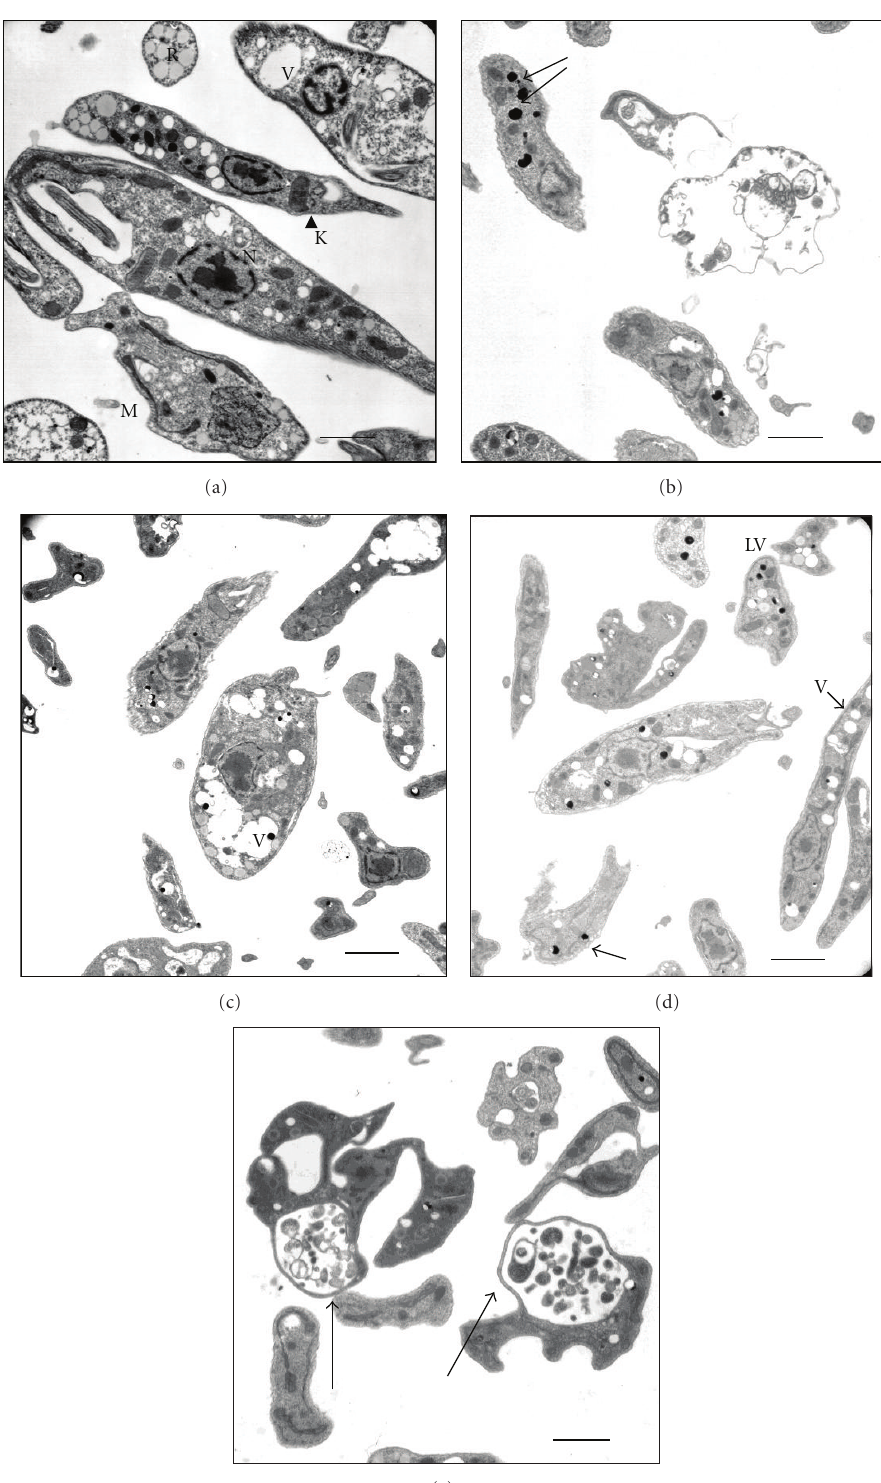
Figure 4: Ultrastructural alterations by TEM in L. infantum treated with the flavonoid derivatives. (a) Control parasite of L. infantum showing organelles with their characteristic features such as the nucleus (N), kinetoplast (K), reservosomes (R), mitochondrion (M), and vacuoles (V) (bar: 1 μ m). (b) L. infantum treated with compound 4 . Electrodense organelles (arrow) (Bar: 1 μ m). (c) L. infantum treated with compound 5 with intense vacuolization (V) (Bar: 1.59 μ m). (d) L. infantum treated with compound 6 , vacuoles (V), lipid vacuoles (LV), and electrodense vesicles (arrow) (bar: 1.59 μ m). (e) L. infantum treated with compound 8 with distorted parasites (arrow) (Bar: 1 μ